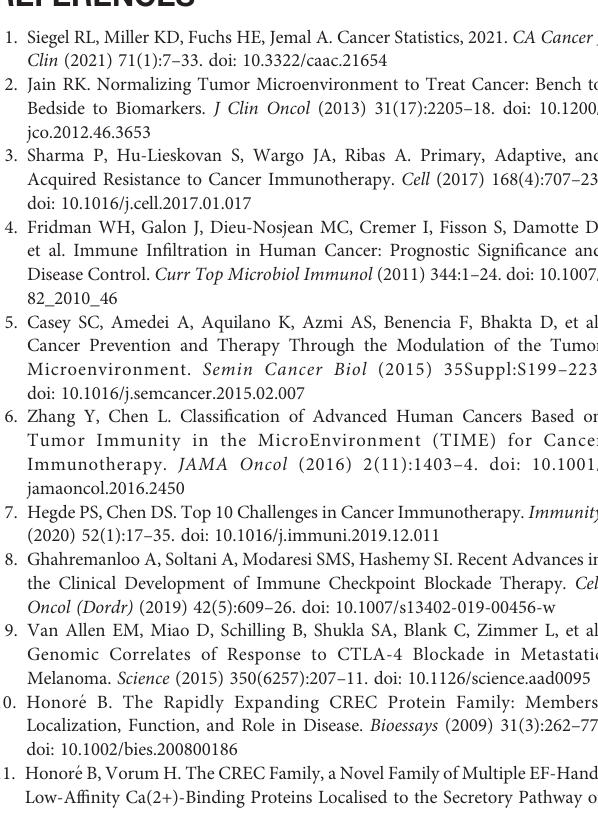
Supplementary Figure 2 | DNA methylation of RCN3 in human cancers. Using the cBioportal tool, we explored the correlations between RCN3 expression and DNA methylation. R>0.3, P<0.05 is considered statistically signi fi cant, and only statistical results are shown here. Supplementary Figure 3 | CNA of RCN3 in human cancers. Using the cBioportal data bank, we analyzed the relationship between RCN3 expression and relative linearcopy-numbervalues. R>0.2,P<0.05isconsidered statisticallysigni fi cant,and only statistical results are shown here. Supplementary Figure 4 | The prognostic signi fi cance of RCN3 in pan-cancer. (A) Univariate Cox proportional-hazards regression used to quantify the relationship of RCN3 with DFI (A) , PFI (B) , and DSS (C) . DFI, disease-free interval; PFI, progression-free interval; DSS, disease-speci fi c survival. Supplementary Figure 5 | Correlation ship of RCN3 and tumor metastasis. High expression of RCN3 share a higher nodal metastasis stage in ACC, COAD, BRCA, and READ (A – D) , and a GSVA analysis of 32 cancer types showed that expression of RCN3 signi fi cantly correlated with the pathway of epithelial mesenchymal transition (EMT) (E) . Supplementary Figure 6 | Gene Set Enrichment Analysis (GSEA) of RCN3 in pan-cancer. (A – F) The plot shows the top 20 pathways enriched in KEGG analysis via GSEA. Signi fi cant KEGG pathways in fl uenced by RCN3 expression in COAD, READ, MESO, LIHC, LGG, and KIRC were analyzed by GSEA. Supplementary Figure 7 | Cell-speci fi c expression of RCN3 was also derived using the UALCAN database and found that notheness in solid or nonsolid tumor cells, RCN3 showed a high expression in immune cells and fi broblast